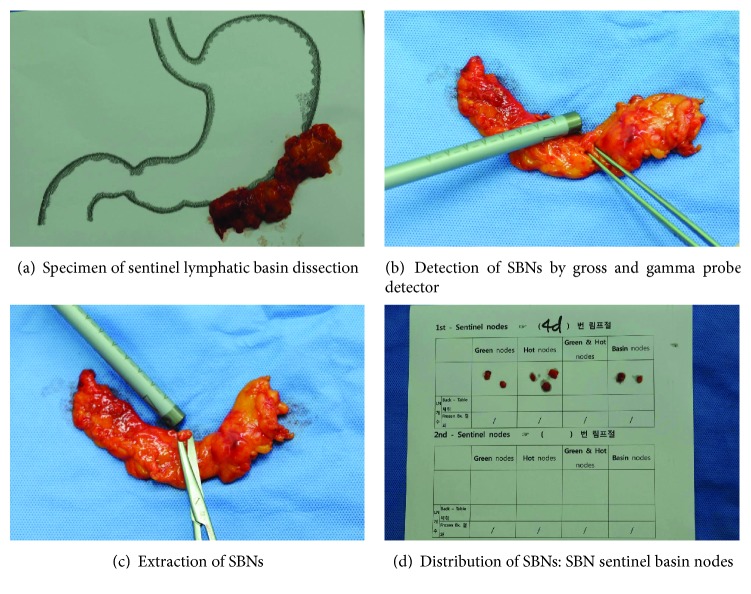
Harvest procedure of sentinel basin nodes at back table.